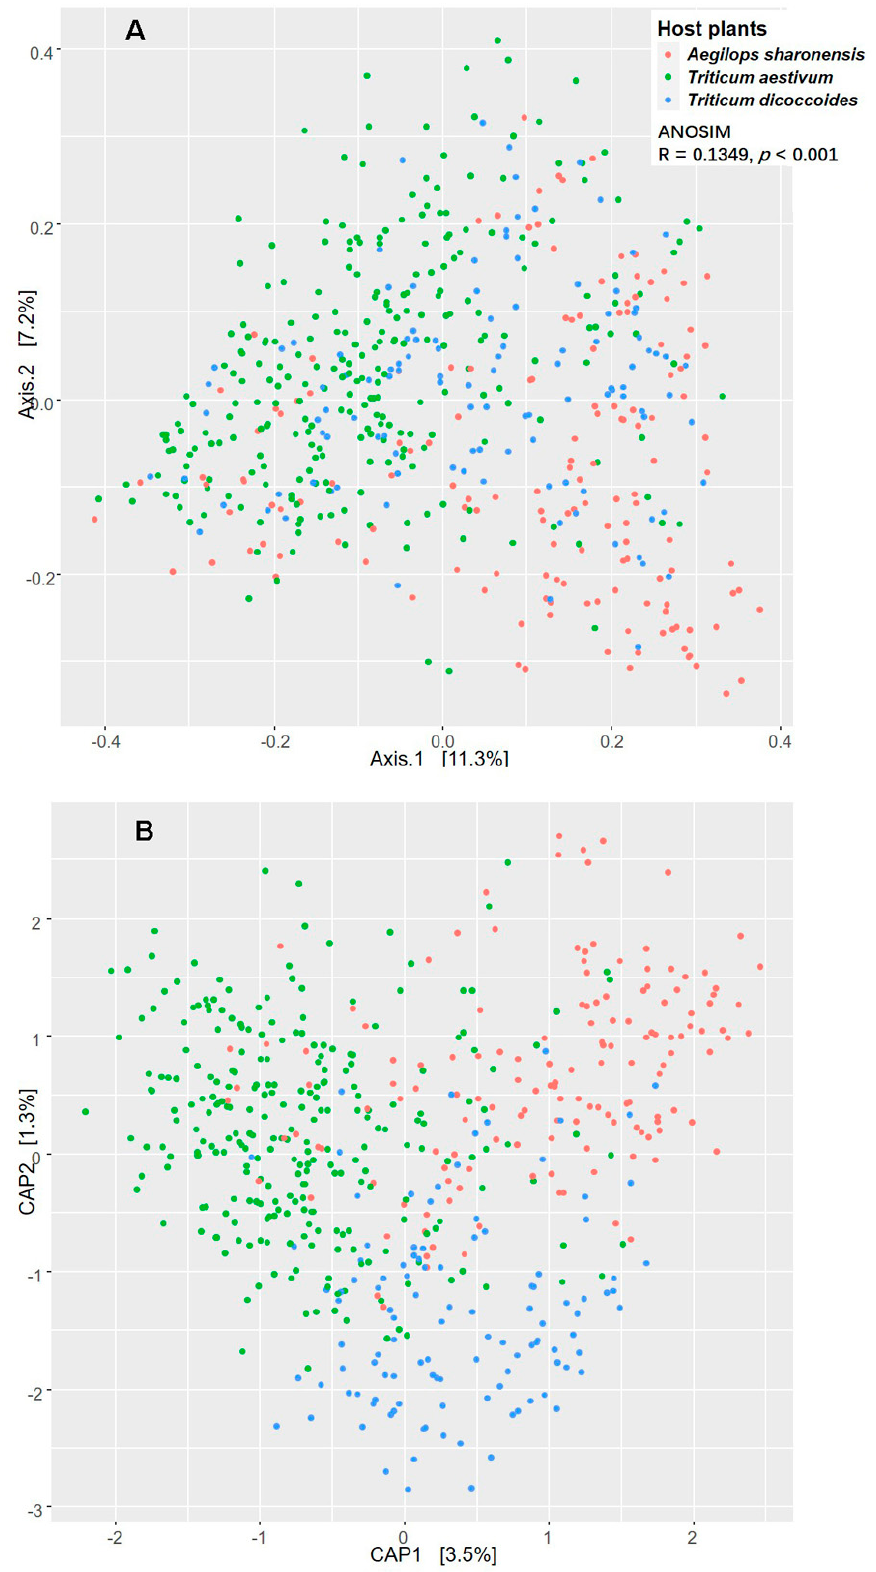
Figure 6. Assessment of the effect of host species on the structure of FECs by PCoA ( A ) and CAP ( B ). The PCoA and CAP ordination based on Bray–Curtis dissimilarity metric were calculated with Hellinger transformed abundance data. ANOSIM shows significance of differentiation among FECs of different species.